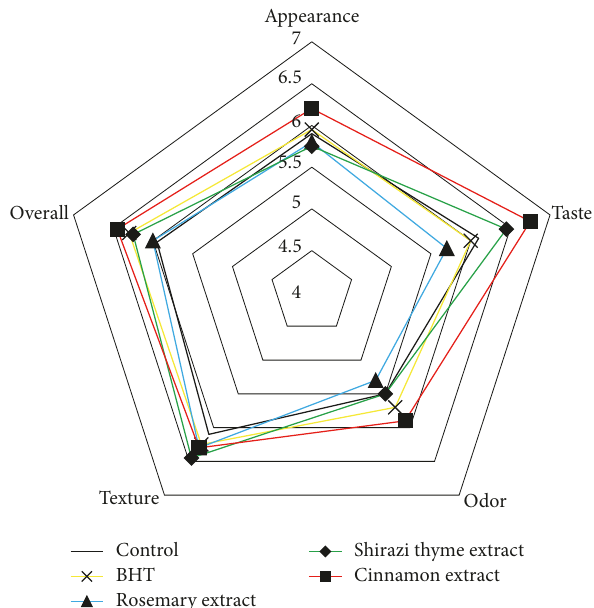
Figure 4: Sensory evaluation of different beef burger formulations; a 9-point descriptive scale (1 = extremely poor and 9 = highly acceptable) was used during